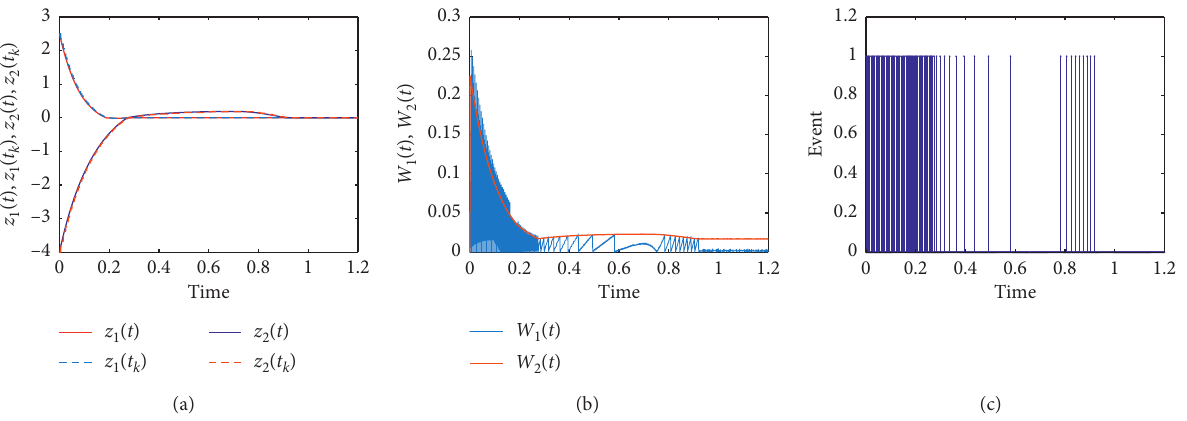
Figure 3: The static event-triggering function (53) with ω � 0 . 25. (a) State trajectories of synchronization error system. (b) Trigger ( t ) � ‖ Δ z ‖ ( t ) � ω ( η − H ‖ z ( t )‖ ) / ( p ) . (c) Event trigger and W parameters W 1 1 2 max 1 max